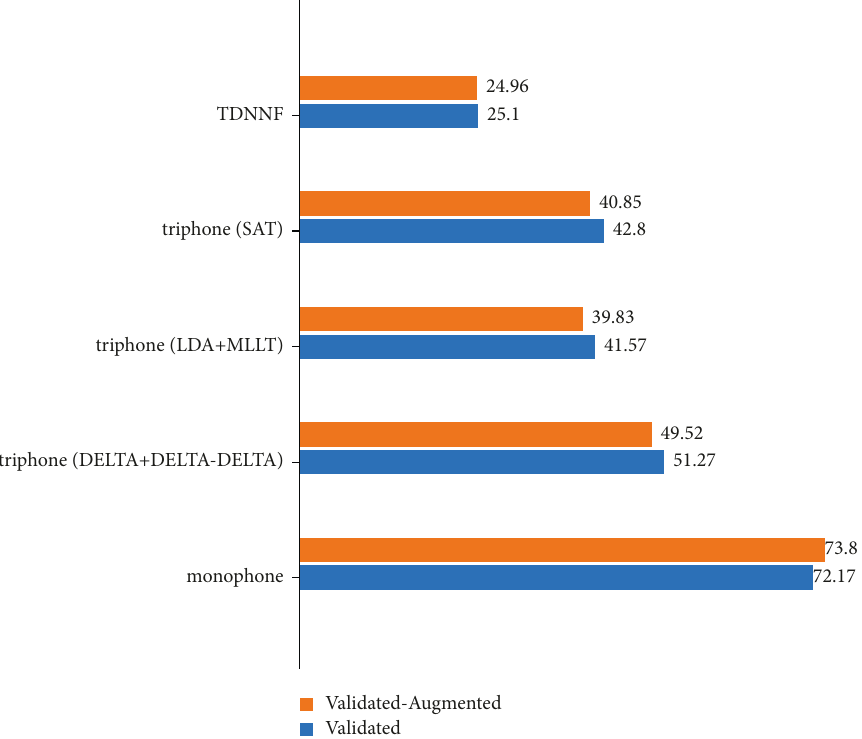
Figure 13: The %WER using 46,550 validated augmented vs. nonaugmented utterances. Table 16: The performance of the models. WER